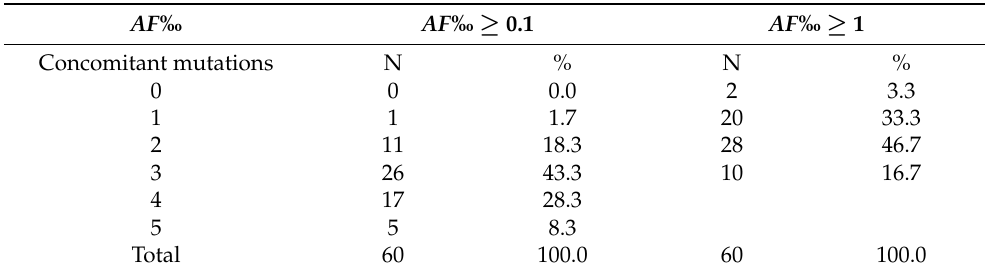
Table 2. The coexistence of KRAS G12/G13, KRAS Q61, NRAS G12/G13, NRAS Q61, BRAFV600, and EGFR exon 19 deletions